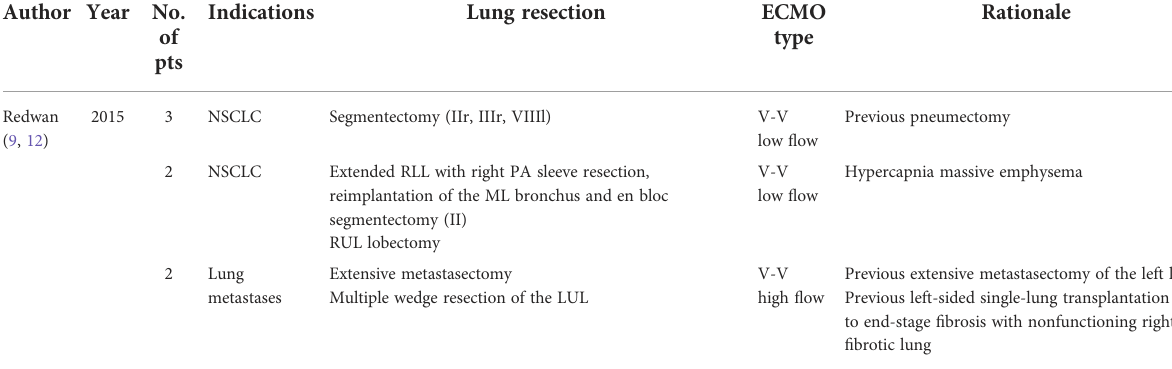
TABLE 1 Studies reporting the use of ECMO in oncological procedures requiring an adequate ventilation. Author Year